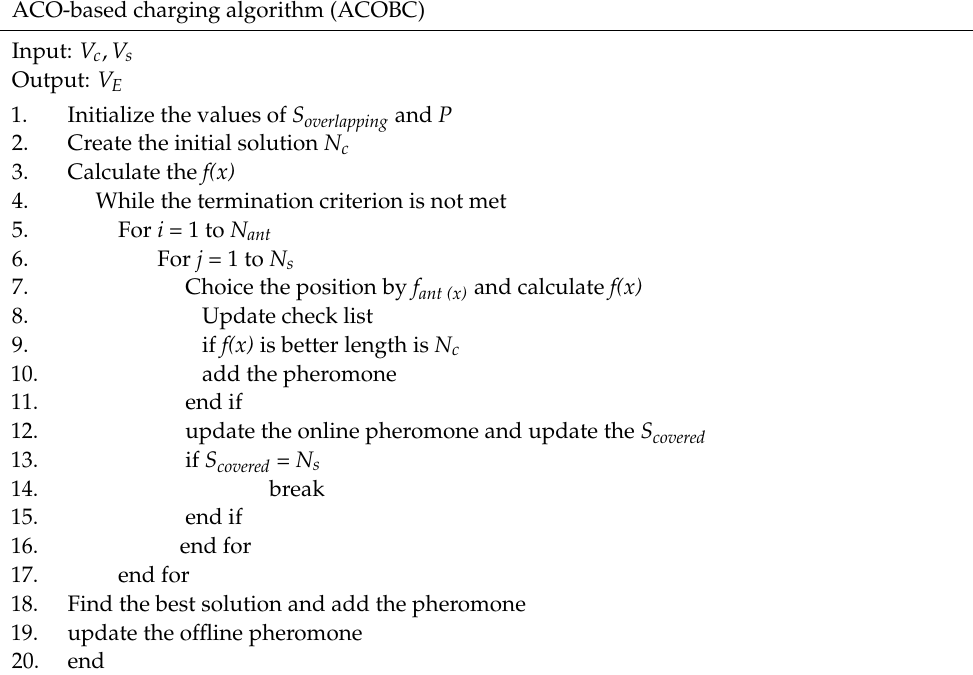
Algorithm 4 ACO-based charging algorithm